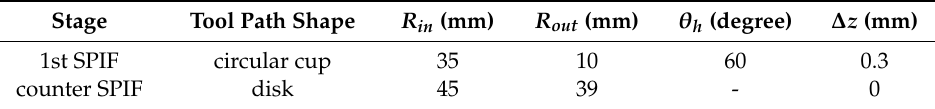
Table 1. Initial experimental conditions of the 1st and the counter